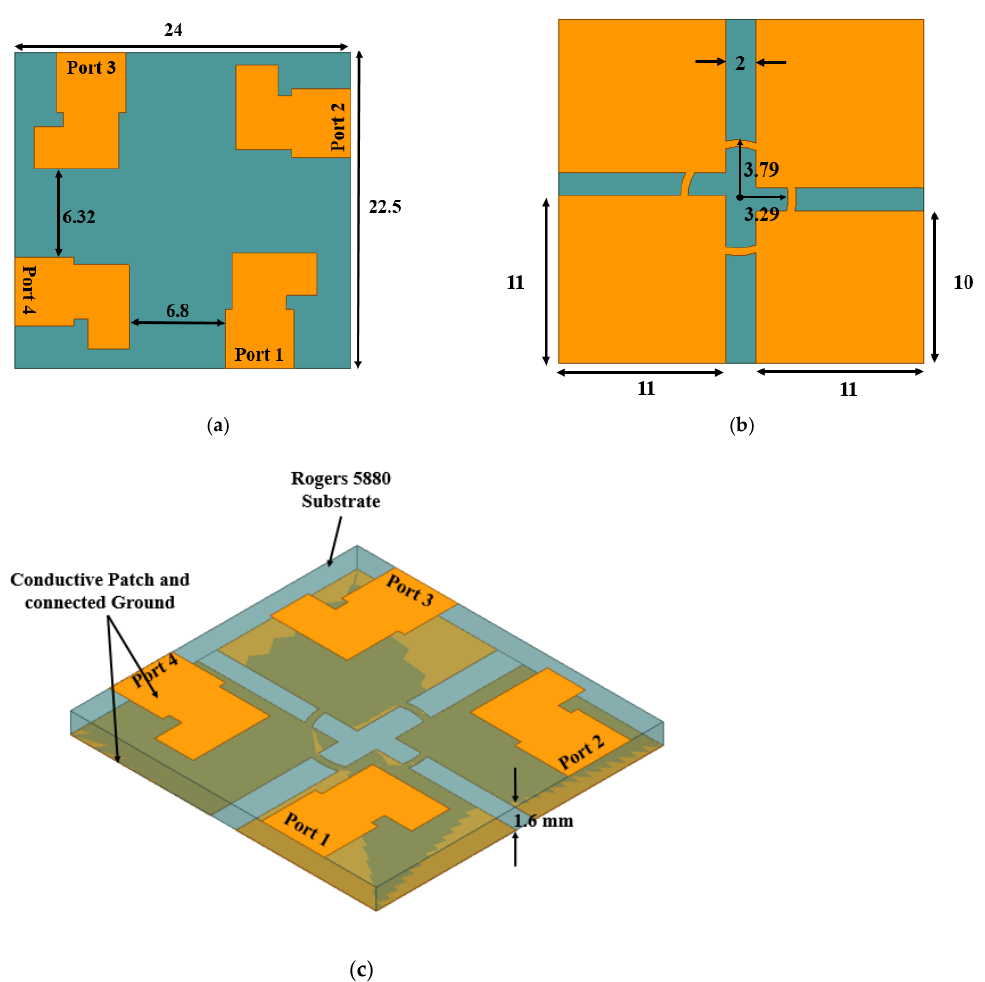
Figure 8. Four-element MIMO antenna: ( a ) top plane; ( b ) bottom plane; and ( c ) side view.